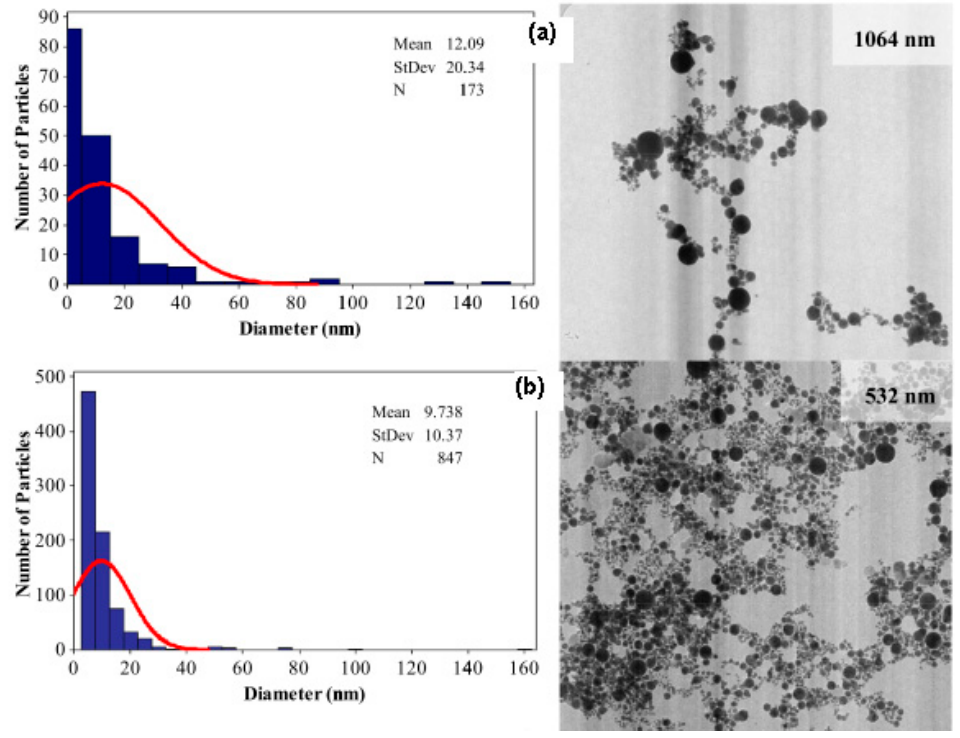
Figure 1. Histogram of the size distribution on TEM images of the gold nanoparticles produced by ( a ) 1064 nm and ( b ) 532 nm in distilled water (retrieved with permission from reference [33]). Furthermore, laser energy contributes to the size of the resultant gold nanoparticle and amount of ablated material. The laser energy is measured in mJ. The linear decay of the ablation rate with spot diameter leads to the inverse-proportional increase of the ablation rate with the square root of the laser fluence [6,20]. An increment in laser energy enhances the number of synthesised gold nanoparticles with larger size distribution, larger nanoparticle sizes and higher solution concentration [33]. However, this effects for materials with lower reflectivity [33]. Enhancing the power ablation to the gold target material will cause a higher detachment of target material, formation of plume and nanoparticles dissolved in a liquid medium and increase solution concentration. High concentration of gold nanoparticles by the PLAL method visually shows a darker colour due to surface plasmon resonance (SPR) characteristic. Apart from fragmentation, explosive boiling and vaporisation that occur simultane- ously, there is high probability occurrence of thermal mechanism at the edge of the crater and fragmentation at the centre part of the laser spot. Due to the multiple ablation mecha- nism, bimodal size distribution is obtained in high laser energy compared with monomodal in lower energy prospectively. A study shows that higher laser energy at 318 mJ will produce smaller average particle sizes of gold nanoparticle (7.516 nm) than that at 286, 226 and 96.6 mJ with particle sizes at 17.5, 25 and 30 nm, respectively, with the same 1064 nm laser ablation wavelength [6]. However, this is in disagreement with a study performed by Jamaludin et al. [32] as shown in Figure